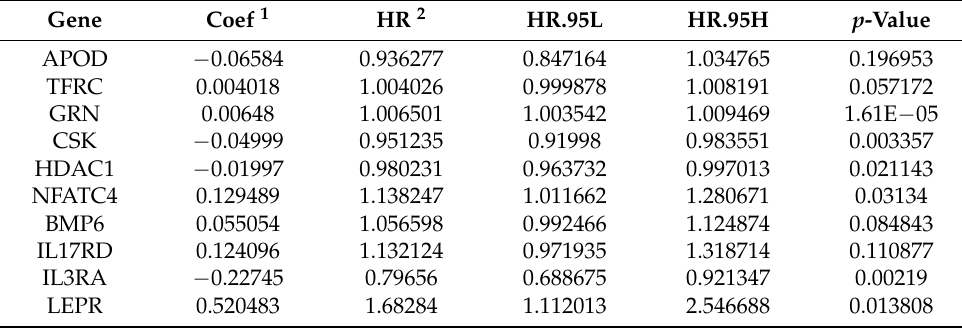
Table 3. The IRGs involved in the predictive